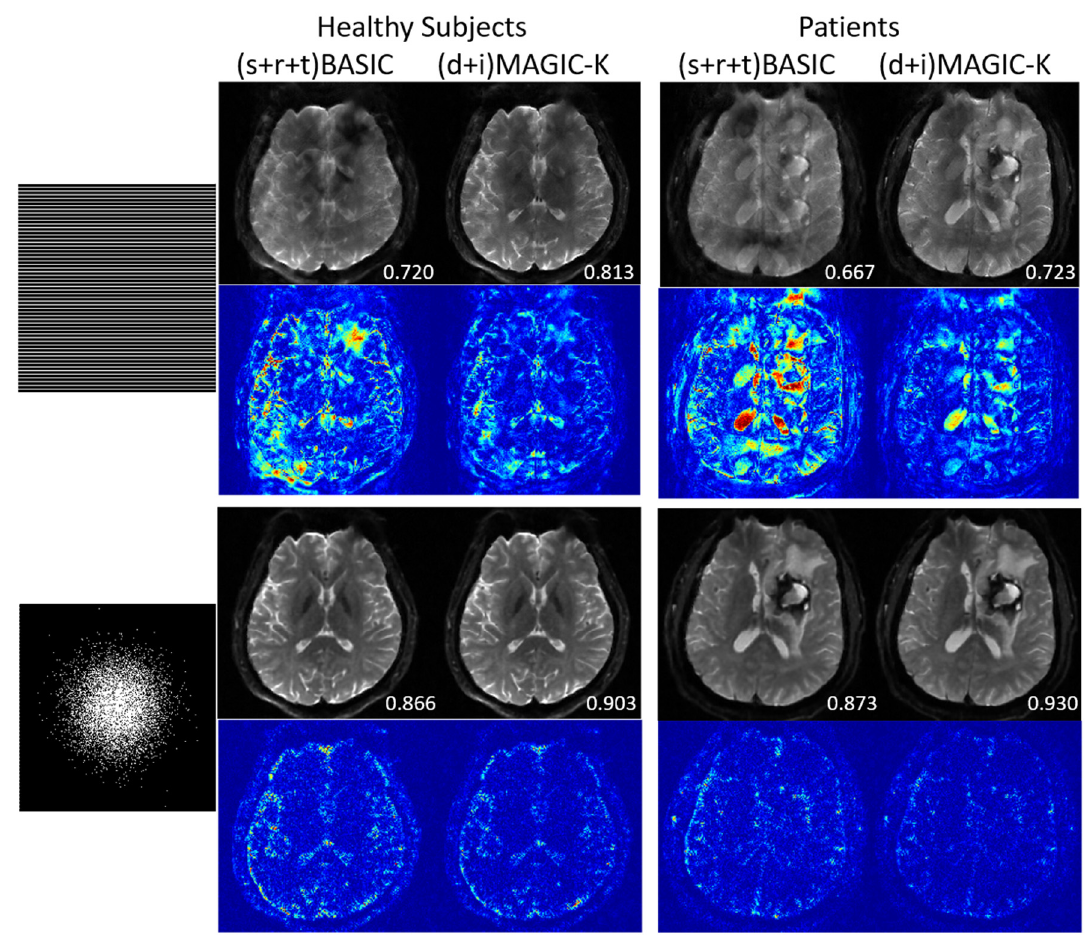
Figure 11. Comparison of the reconstructed images by data augmentation strategies of (s + r + t) BASIC and (d + i) MAGIC-K, using uniform undersampling with an acceleration factor of 6 (UR6) and variable density undersampling with an acceleration factor of 6 (VR6). The SSIM is listed at the bottom-right of each reconstructed image. The error map was × 10 amplified for better visualization.